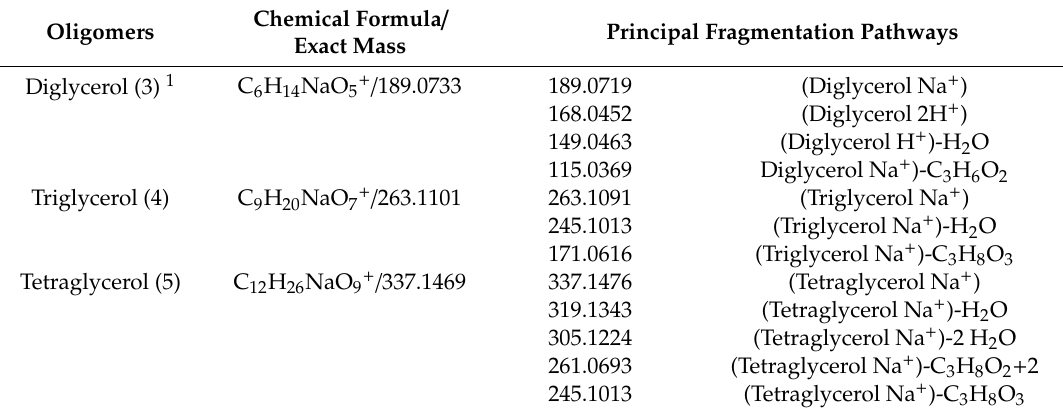
Figure 11. ESI(+)-MS of oligomers obtain from the etherification of glycerol. Figure 11. ESI( + )-MS of oligomers obtain from the etherification of glycerol. Table 5. Principal fragmentation pathways of linear Table 5. Principal fragmentation pathways of linear polyglycerols.